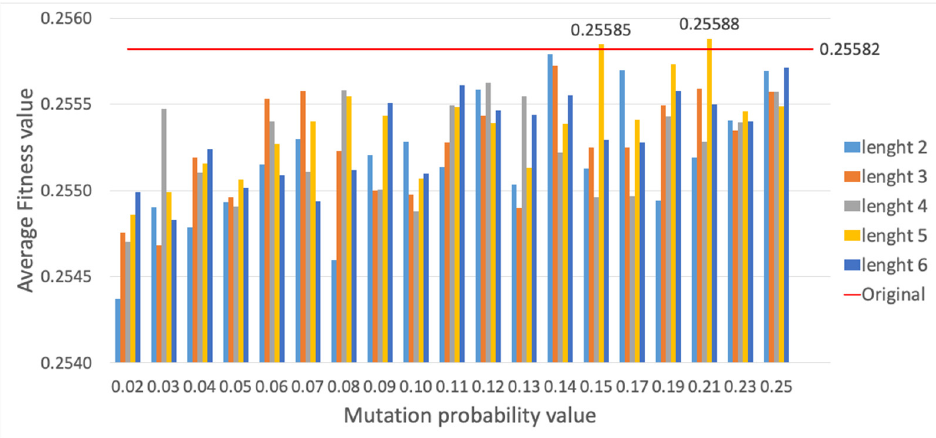
Figure 19. Average fitness value of the best individual for RSM method vs. different mutation probability values.